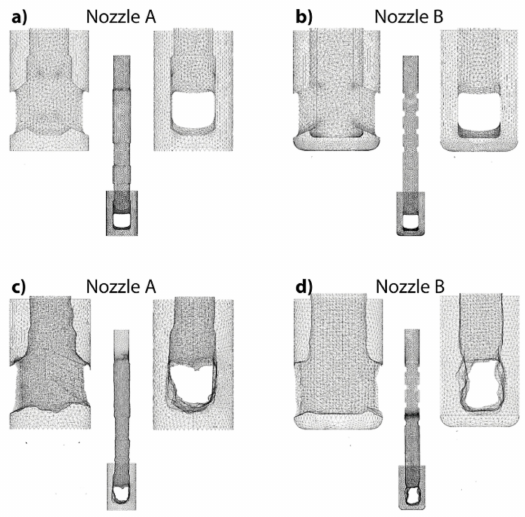
Figure 6. Computational meshes in the region of the ports. ( a ) Nozzle A without clogging. ( b ) Nozzle B without clogging. ( c ) Nozzle A with clogging. ( d ) Nozzle B with clogging.